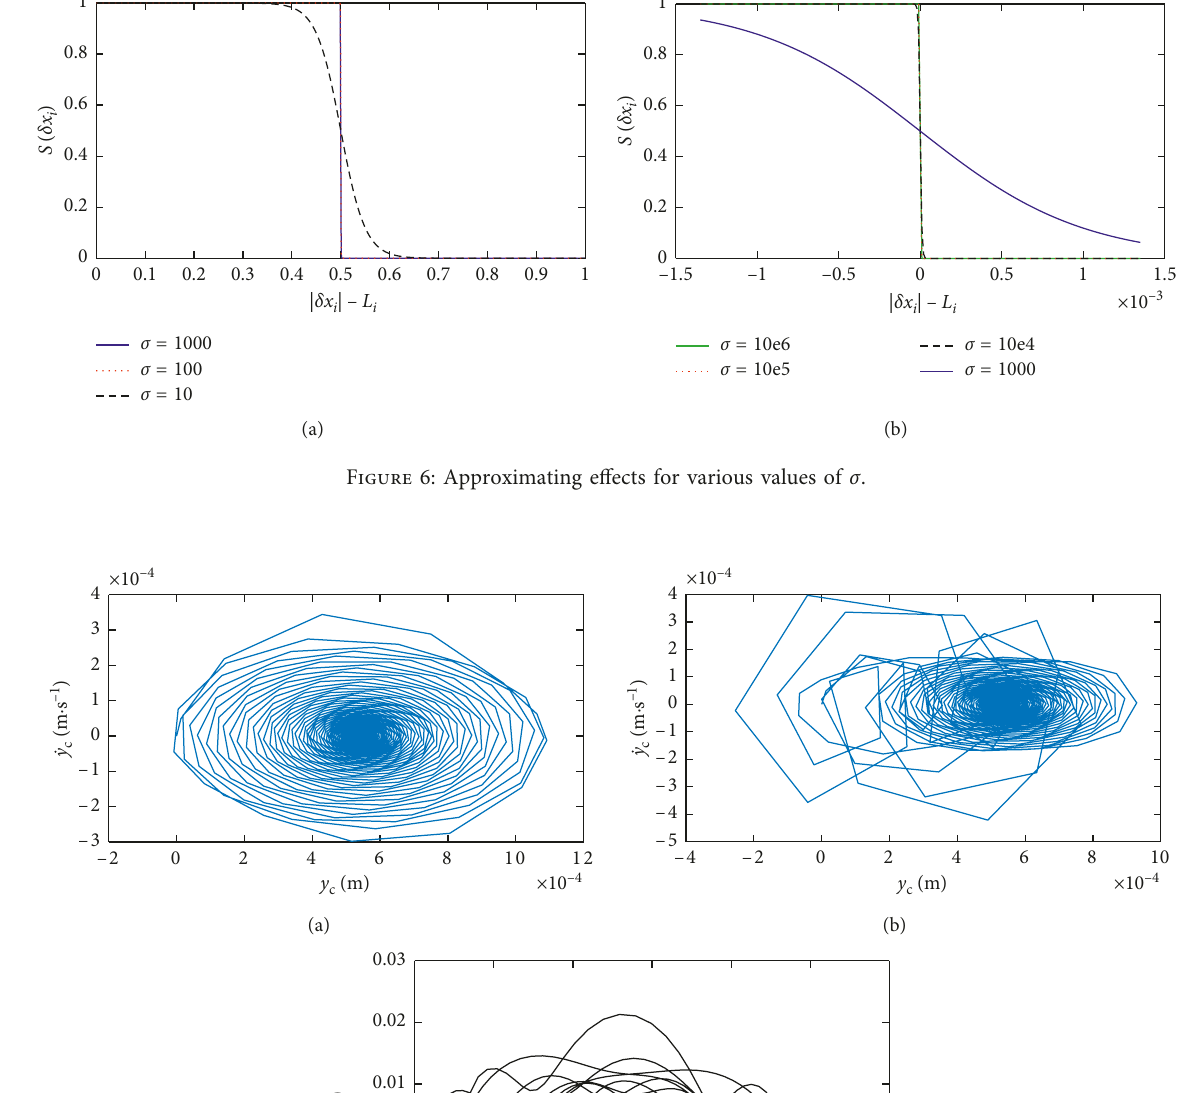
Phase diagrams have been used to judge whether the behaviors of the dynamical system are cyclic. Generally, if